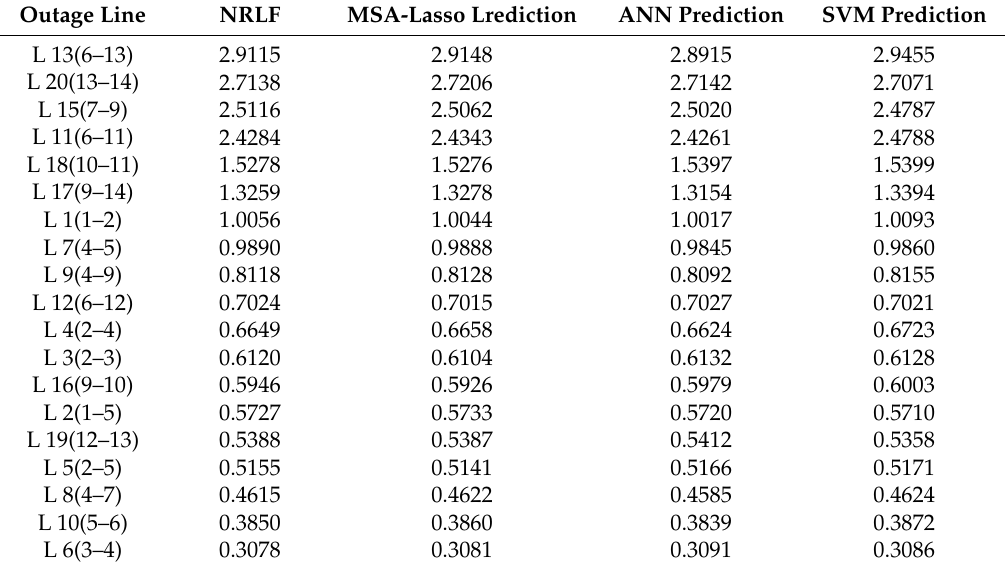
Table 11. Security index results of each method in the heavy load condition of the IEEE 14-bus